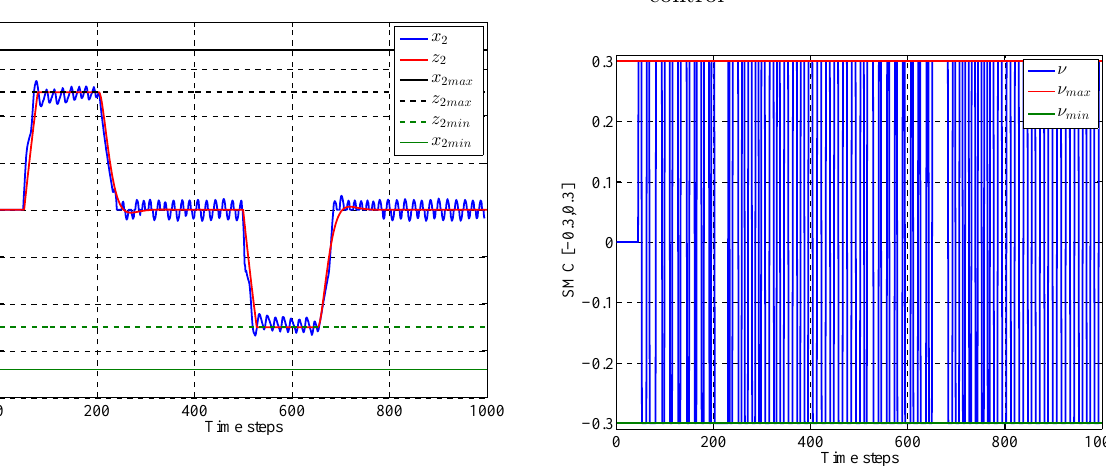
Figure 9: Traditional SMC component of the proposed